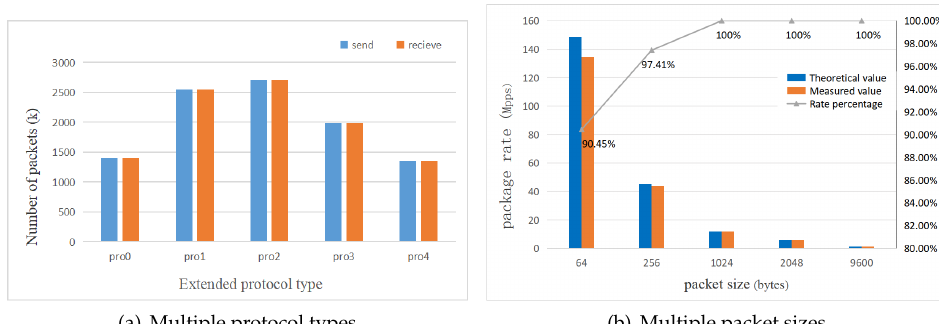
Figure 9. Statistics of sending and